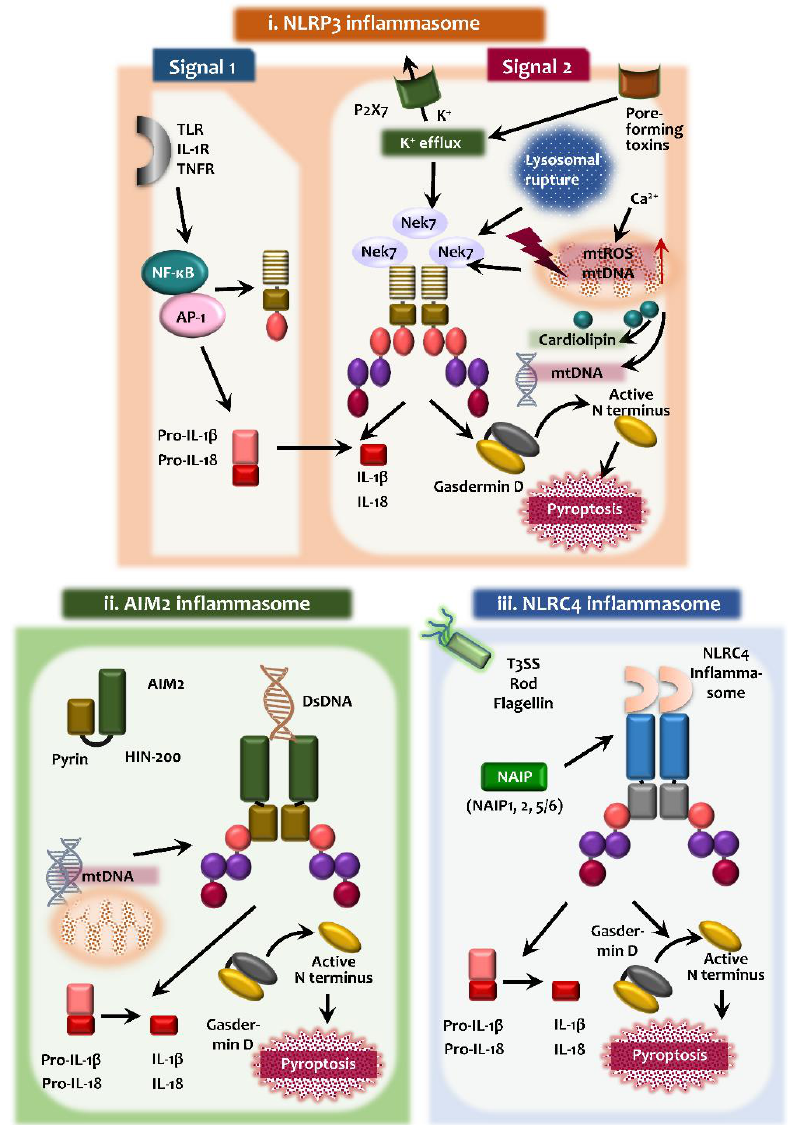
Figure 1. Inflammasome activation. ( i ) A priming signal (signal 1) is necessary for NLRP3 inflammasome activation in response to secondary signal (assembly signal 2). The priming signal through various innate and cytokine receptors such as TLR, IL-1R, and TNFR which activates the transcriptional factor NF- κB to increase the expression of NLRP3 and pro -forms of IL- 1β and IL -18. The signal 2 activation by P2X7 receptors, pore forming toxins induce NLRP3 inflammasome assembly and caspase-1 activation leading to processing of pro-forms of IL- 1β and I L-18, and the secretion of mature cytokines. Lysosomal destabilization, and mitochondrial damage also induces the NLRP3 activation. A serine-threonine kinase NEK7 facilitates NLRP3 oligomerization. ( ii ) AIM2 inflammasome activation is triggered by sensing the presence of double-stranded DNA. The positively charged surface of the HIN-200 domain binds to the DNA, and the pyrin domain engages to ASC for inflammasome complex assembly. AIM2 can sense the self-DNA and are associated with various pathological conditions. ( iii ) For the activation of NLRC4 inflammasome, NAIP acts as cytosolic receptor for a variety of bacterial protein (T3SS, Flagellin, etc.) and co-assemble into NLRC4 inflammasome complex. All the inflammasome activation lead to pyroptosis through gasdermin D that acts as a key substrate of inflammatory caspases. TLR, Toll-like receptor; IL-1R, interleukin 1 receptor; TNFR, tumor necrosis factor receptor; P2X7, P2X purinoreceptor 7; NEK7, NIMA related kinase 7; T3SS, type III secretion systems. Upward arrow ( ↑ ) in red represents increase / induction; all other black arrows represent signaling